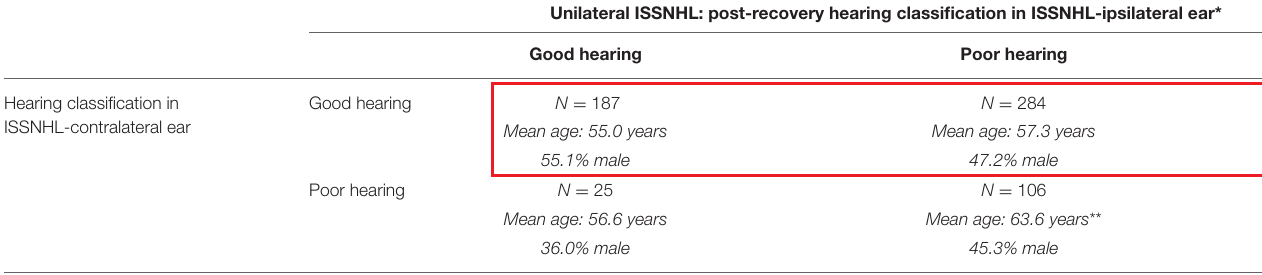
TABLE 2 | The demographics in the patients with audiometrically-confirmed unilateral ISSNHL, segmented by degree of hearing recovery post-ISSNHL.